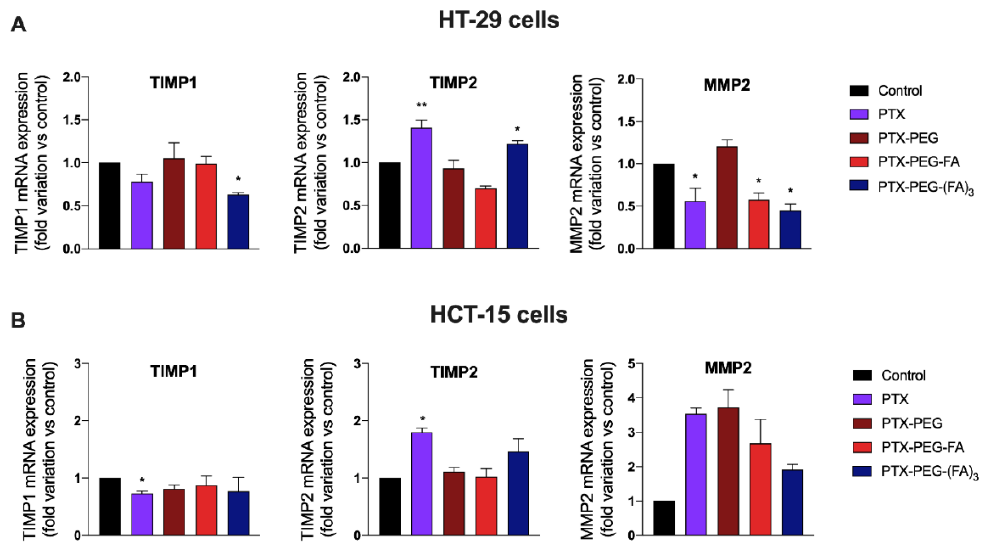
Figure 8. Effect of PTX and PTX conjugates on the mRNA expression of the TIMP1, TIMP2 and MMP2 on HT-29 ( A ) and HCT-15 ( B ) cells. * p < 0.05, ** p < 0.01, vs. control cells. The results are the mean of three independent experiments, each performed in triplicate.